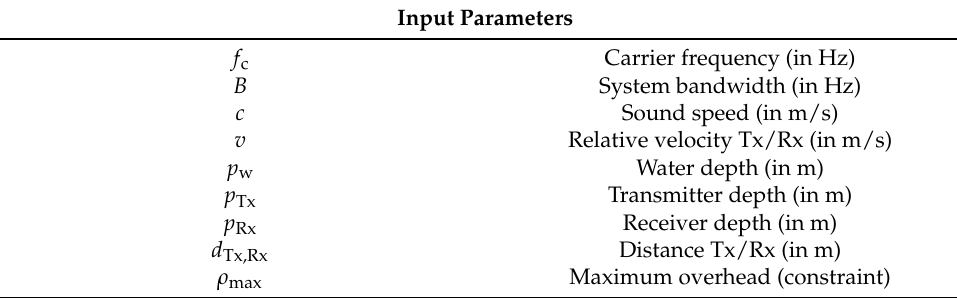
Table 1. Optimization input parameters.